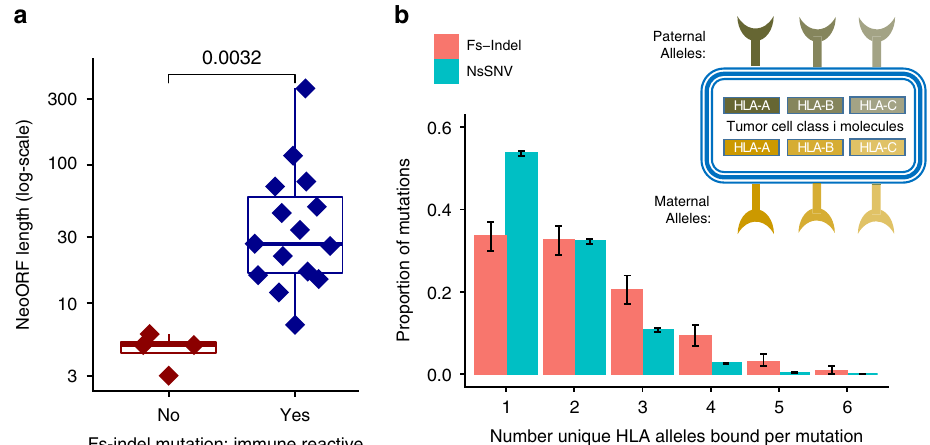
Fig. 6 Direct evidence of T cell reactivity to fs-indel peptides. a Shows the neo open reading frame (neoORF) length, from functional T cell reactivity screening data from recent personalized vaccine and CPI studies. In dark red are lengths from fs-indel peptides which were non-reactive, in dark blue are lengths from fs-indel peptides which were T cell reactive. Two-sided Mann – Whitney U test was used to assess for a difference between groups, with n = 19 mutations in total. b Shows the number of unique class I HLA alleles that individual nsSNV and fs-indel mutations were found to bind against in pan-cancer TCGA data. In all boxplots in this fi gure the centre line is the median, the bounds of the box represent the inter-quartile range, the lower whisker = max (min(x), Q_1 − 1.5 × IQR) and upper whisker = min(max(x), Q_3 + 1.5 ×